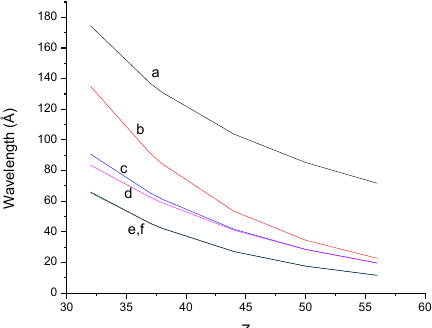
Figure 1. Transition wavelengths from ground state 2s 2 2p 2 P° 1/2 as a function of Z where curves a, b, c, d, e, f represent transitions to 2s2p 2 4 P 1/2 , 2s2p 2 4 P 3/2 , 2s2p 2 2 D 3/2 , 2s2p 2 2 P 1/2 , 2s2p 2 2 P 3/2 , and 2s2p 2 2 S 1/2 levels, respectively.